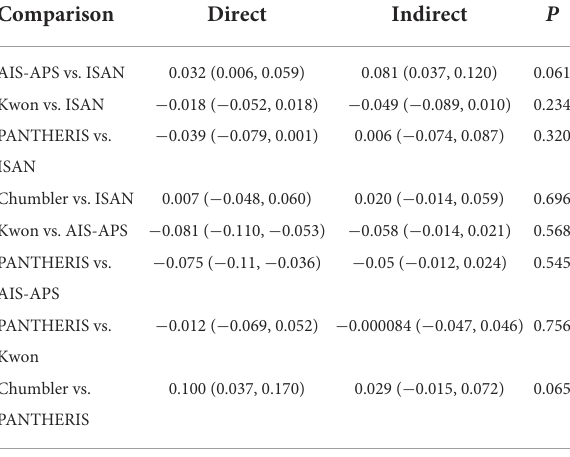
TABLE 2 The results of node-splitting method for inconsistency